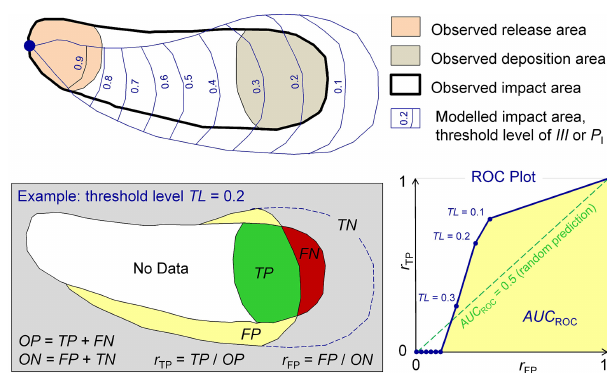
Figure 3. Model validation with an ROC plot, relating the false pos- itive rate r FP and the true positive rate r TP . This way of validation is suitable for predictor raster maps in the range 0–1, such as III or P I . It can also be used for binary predictor maps (0 or 1). In such a case AUC ROC is computed from two threshold levels